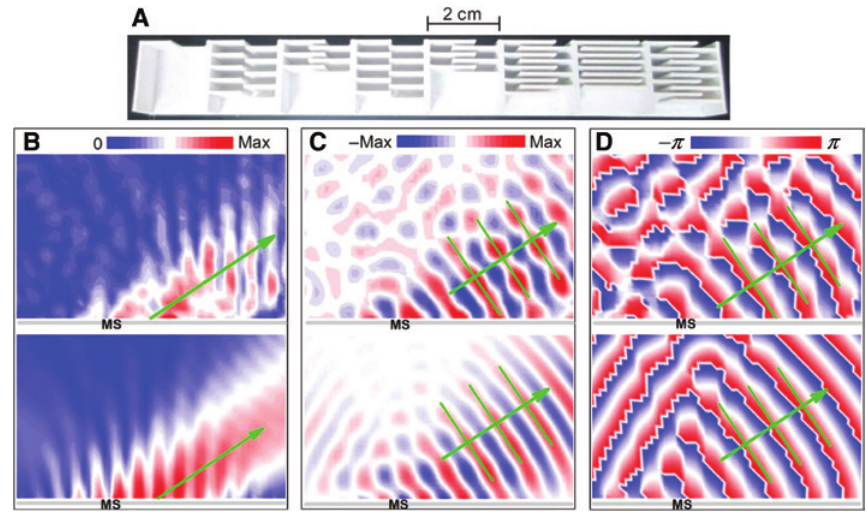
Figure 7: Transmission-type acoustic metasurfaces by coiling up spaces. (A) Experimental sample (photo). (B–D) Measured (upper panels) and simulated (lower panels) amplitude, temporal, and phase field distributions, respectively. The green arrows indicate the propagating wavefronts predicted by generalized Snell’s law (reprinted from Ref. [41]).